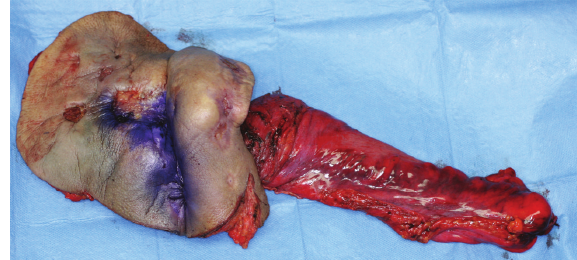
Figure 6: The excised specimen. The buttock skin, sacrococcyx and rectum were excised